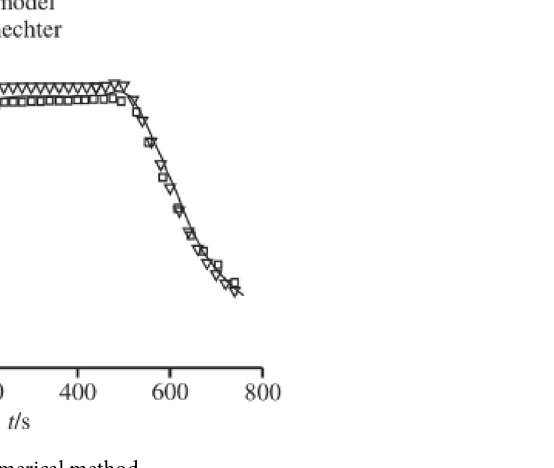
Figure 2. Validation for the numerical